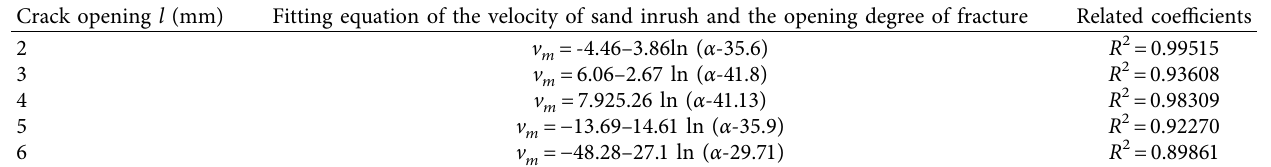
Figure 10: The curve of the relationship between the opening degree of fracture and the velocity of sand inrush. Table 2: Effect of fracture angle on the rate of collapse under different fracture size.